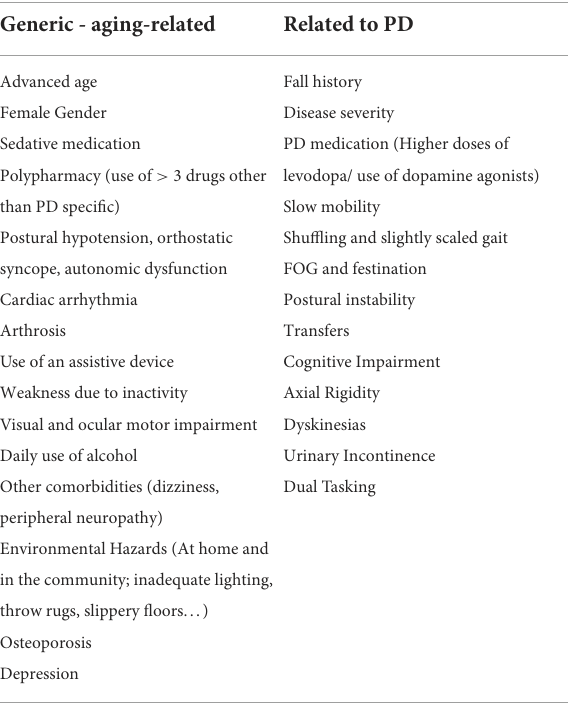
TABLE 3 Fall classification in Parkinson’s disease. Falls classification